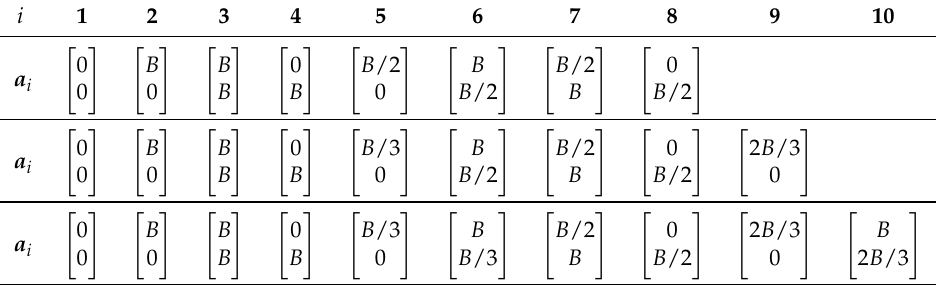
Table 2. Fixed anchors locations (m) in the second considered scenario.